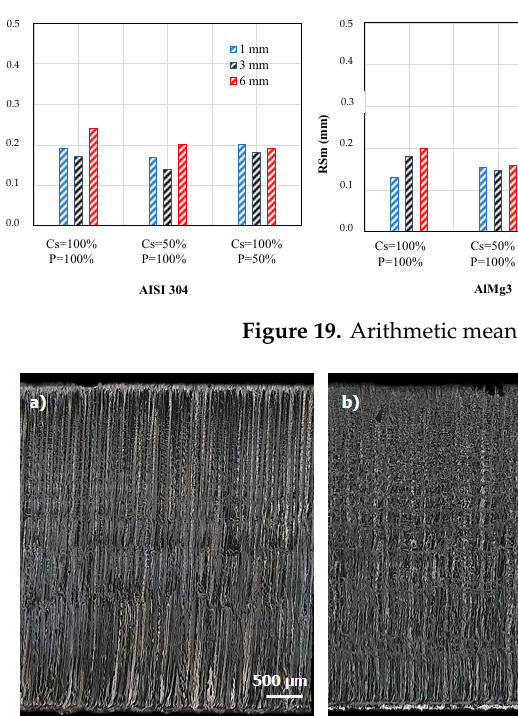
Figure 23. Deviation of drag lines (in accordance with ISO 17658:2015) in 2.5 mm thick St37-2 cut with Cs = 100% and P = 50%.